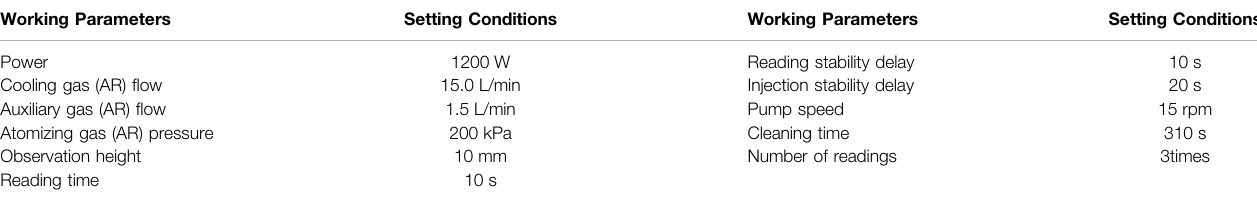
TABLE 1 | ICP-OES Instrument Operating Conditions. Working